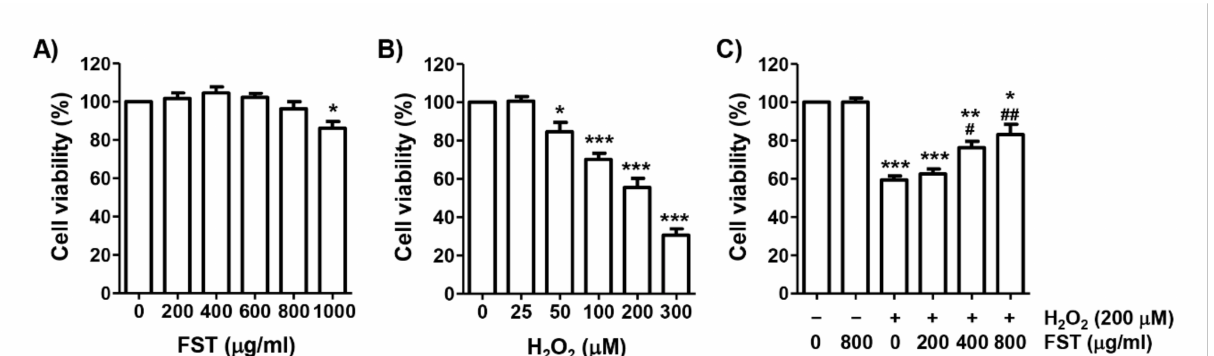
Figure 1. Effect of fermented sea tangle extract (FST) on hydrogen peroxide (H 2 O 2 )-induced cytotoxicity of MC3T3-E1 cells. ( A , B ) Cells were treated with FST or H 2 O 2 for 24 h ( A , B ). ( C ) Cells were treated with or without FST for 1 h prior to exposure to (200 µ M H 2 O 2 for 24 h. Cell viability was presented as the survival rate of cells relative to that of the untreated control cells. * p < 0.05, ** p < 0.01 *** p < 0.001 vs. control cells. # p < 0.05, ## p < 0.01 vs. H 2 O 2 -treated